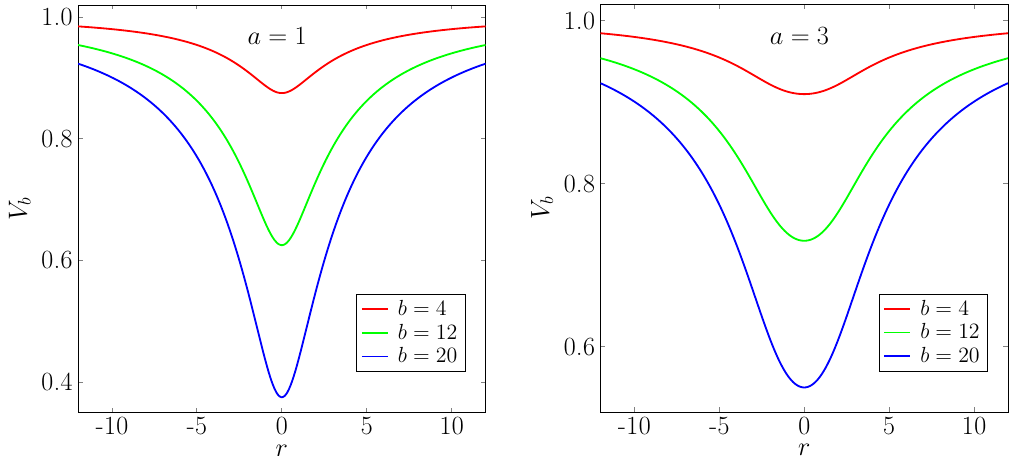
(cid:0) (cid:1) b A / C 2 of massless particles for the ansatz (28): a = 1 −